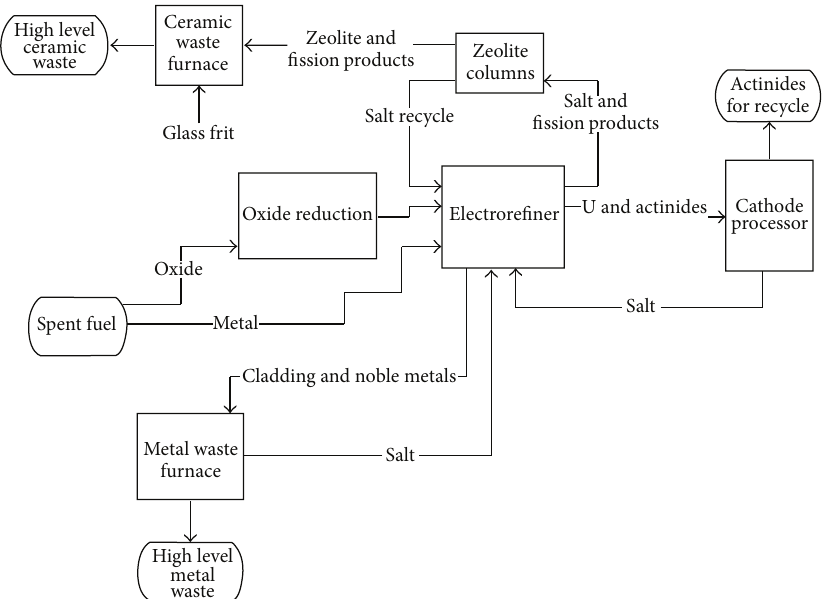
Figure 1: Sample flowsheet for